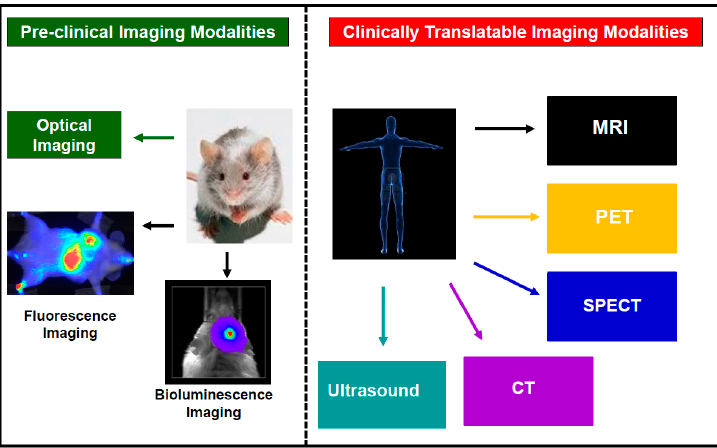
Figure 2. Schematic representing the different imaging modalities used in tracking cell-based therapies both preclinically and clinically. The following imaging modalities are abbreviated in the figure above: magnetic resonance imaging (MRI), positron emission tomography (PET); single photon emission computed tomography (SPECT); and computed tomography.